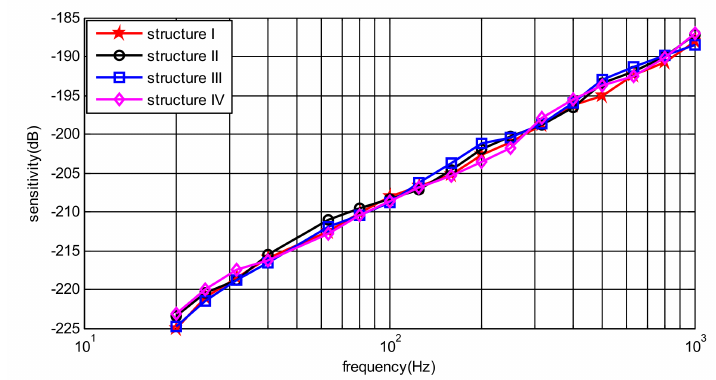
Figure 12. Sensitivity curves of the array MEMS hydrophone in Xn direction.